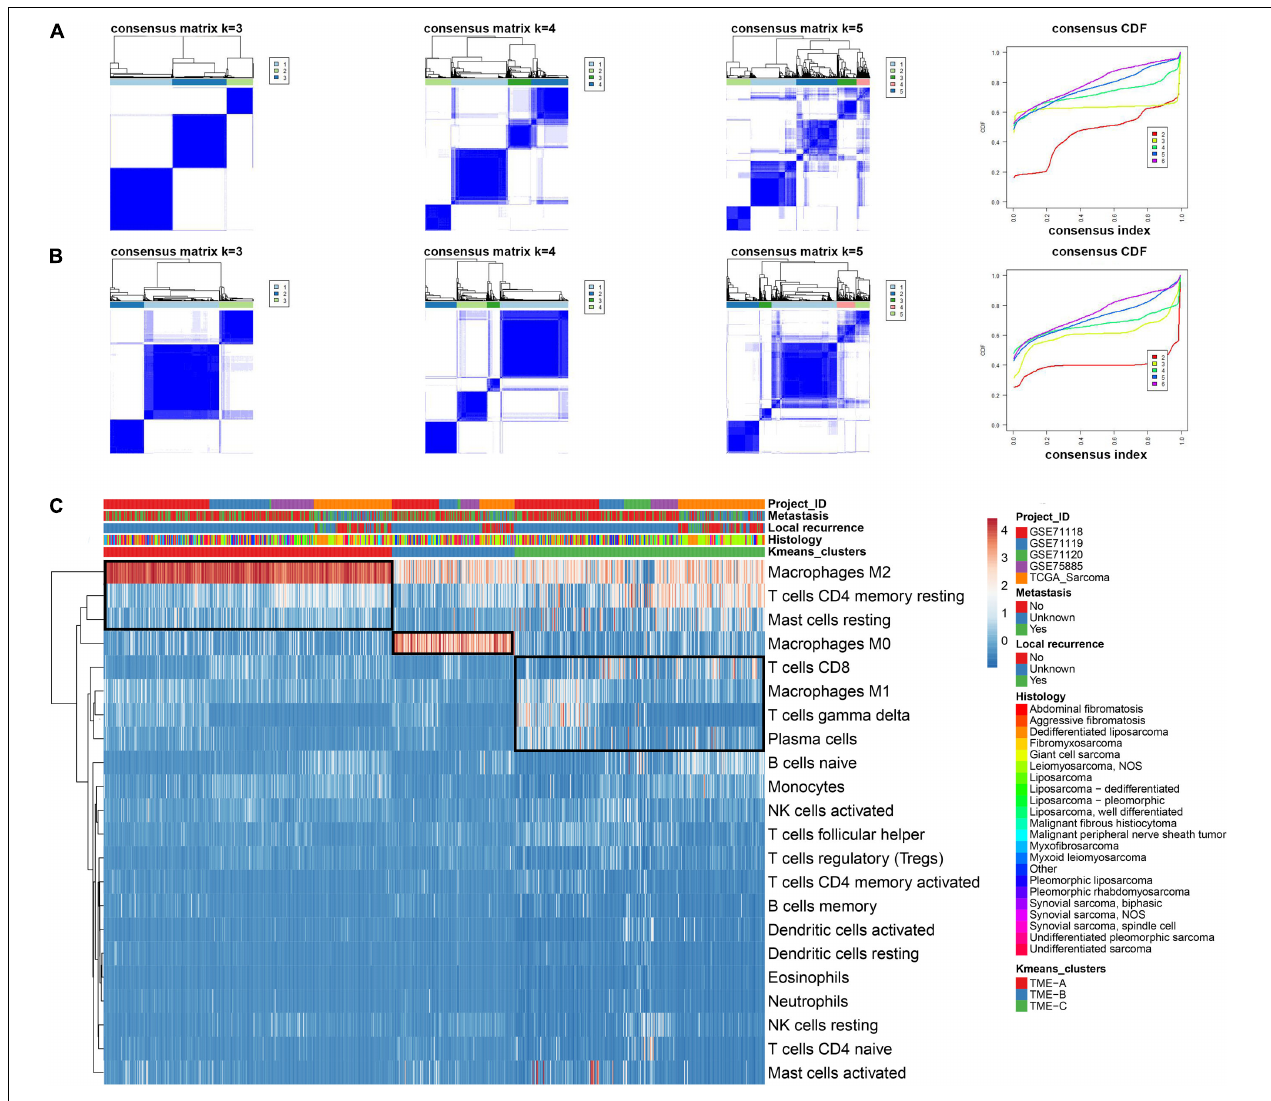
FIGURE 1 | Consensus clustering of immune cell infiltration in 869 sarcoma samples. (A) Consensus clustering matrix for k = 3 to k = 5 using the K-means clustering method. The three heatmaps denote the consensus matrices of sample pairs. Each matrix item calculates the proportion of times that the pair of samples are clustered together across the resampling iteration. The consensus CDF curves are shown for different k from 2 to 6. (B) Consensus clustering matrix for k = 3 to k = 5 using pam clustering method. (C) The Infiltration performance of 22 immune cell types in three TME clusters and five independent sarcoma cohorts. Rows represent immune cells and columns represent samples. Euclidean distance and Ward linkage preform on the hierarchical clustering of all TME